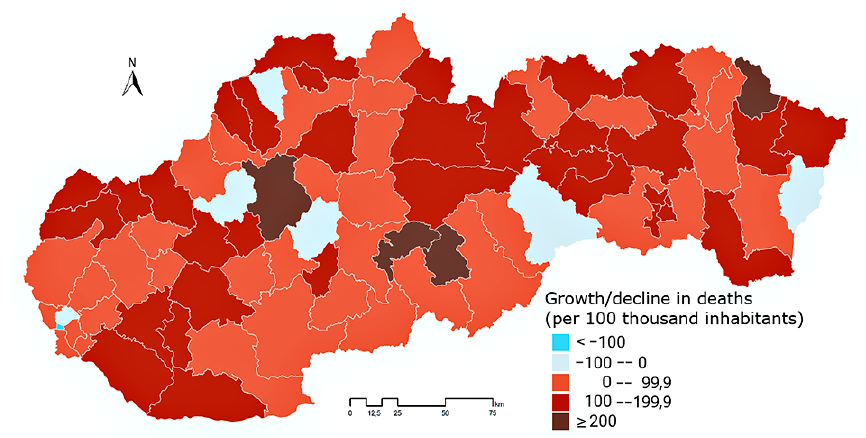
Figure 11. Growth (decline) of deaths in districts of Slovakia in 2020